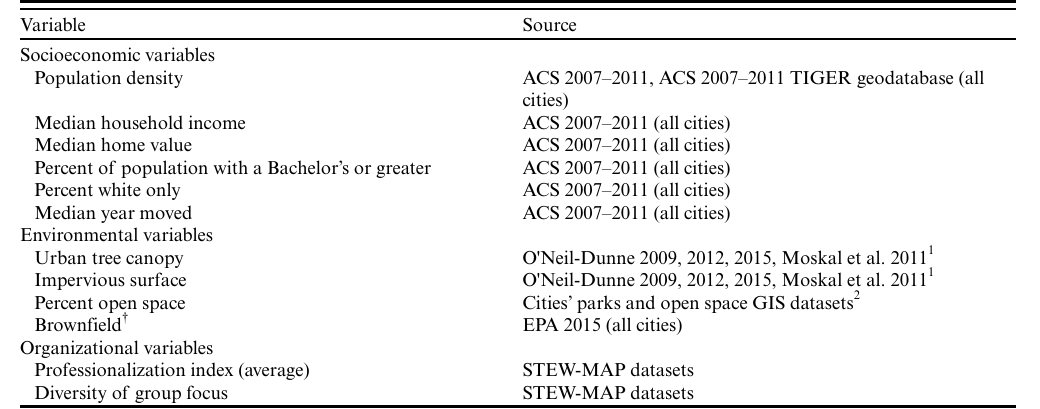
Table 3 . Predictor variables used in Poisson and spatial regressions. ACS, American Community Survey; STEW-MAP, Stewardship Mapping and Assessment